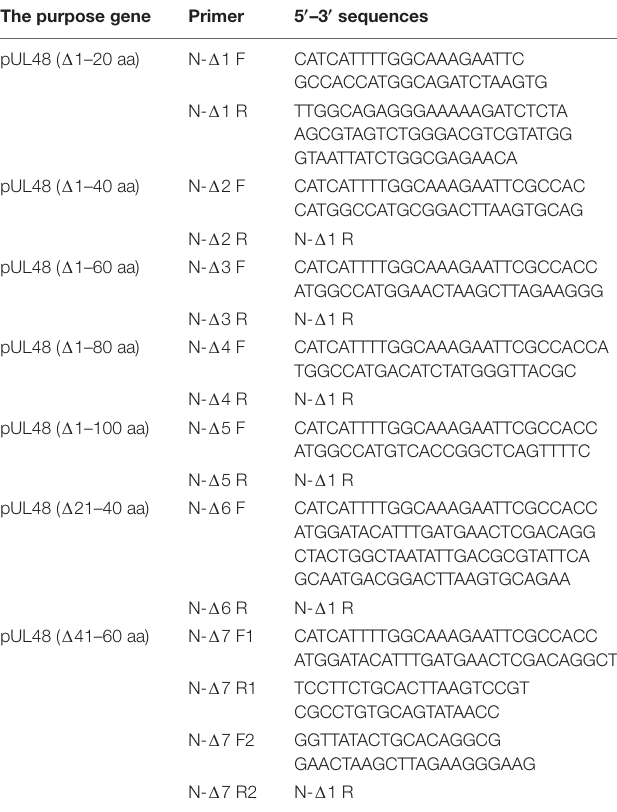
TABLE 3 | Design of pUL48-truncated eukaryotic expression plasmid primer. The purpose gene